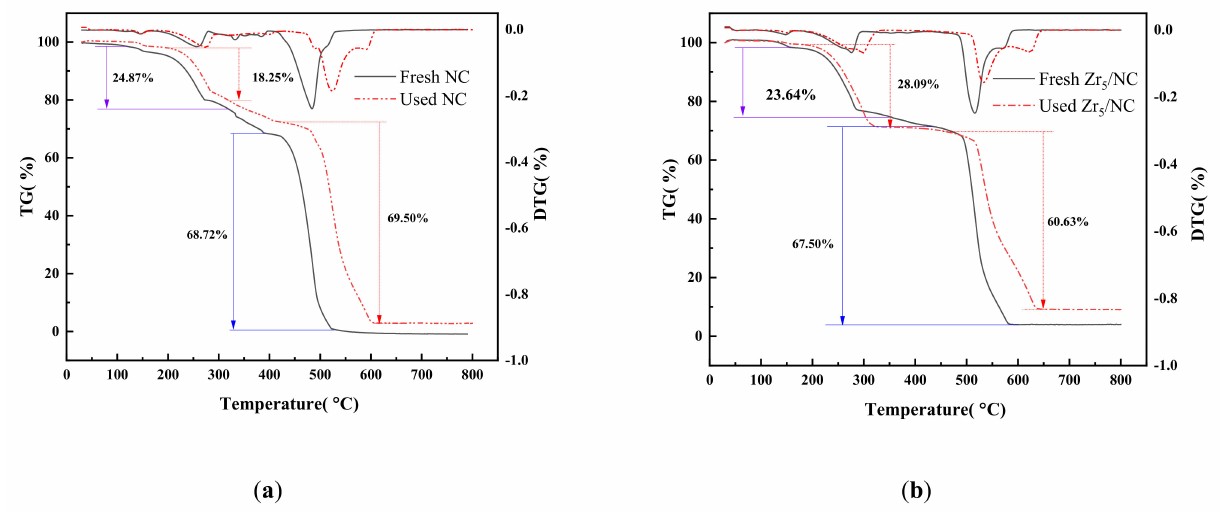
Figure 3. TGA and DTG curves of catalysts. ( a ) TG result of NC, and ( b ) TG result Zr 5 /NC.